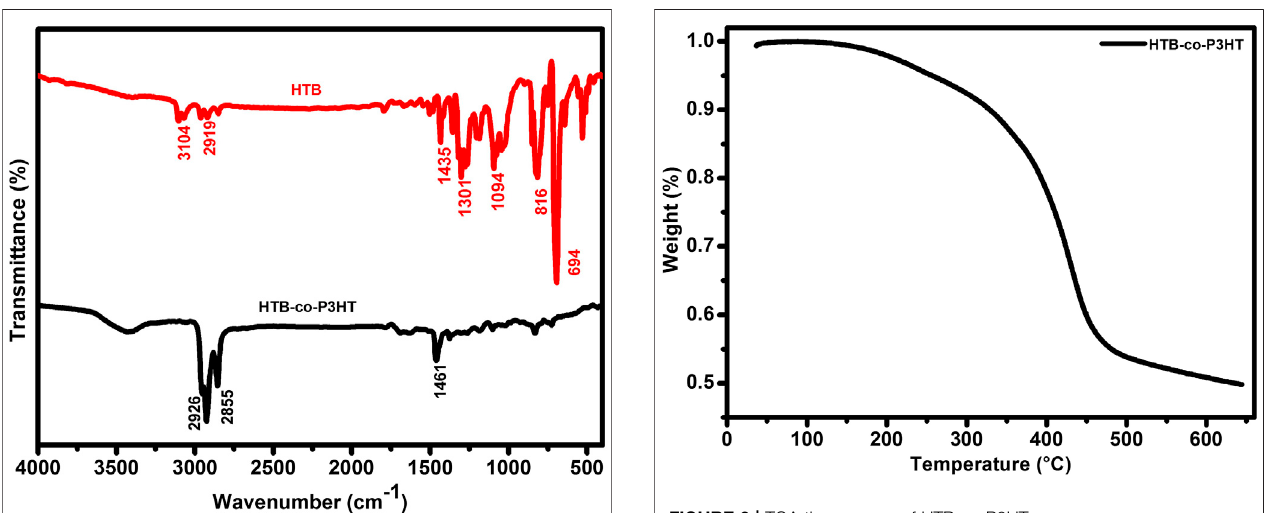
FIGURE 3 | TGA thermogram of